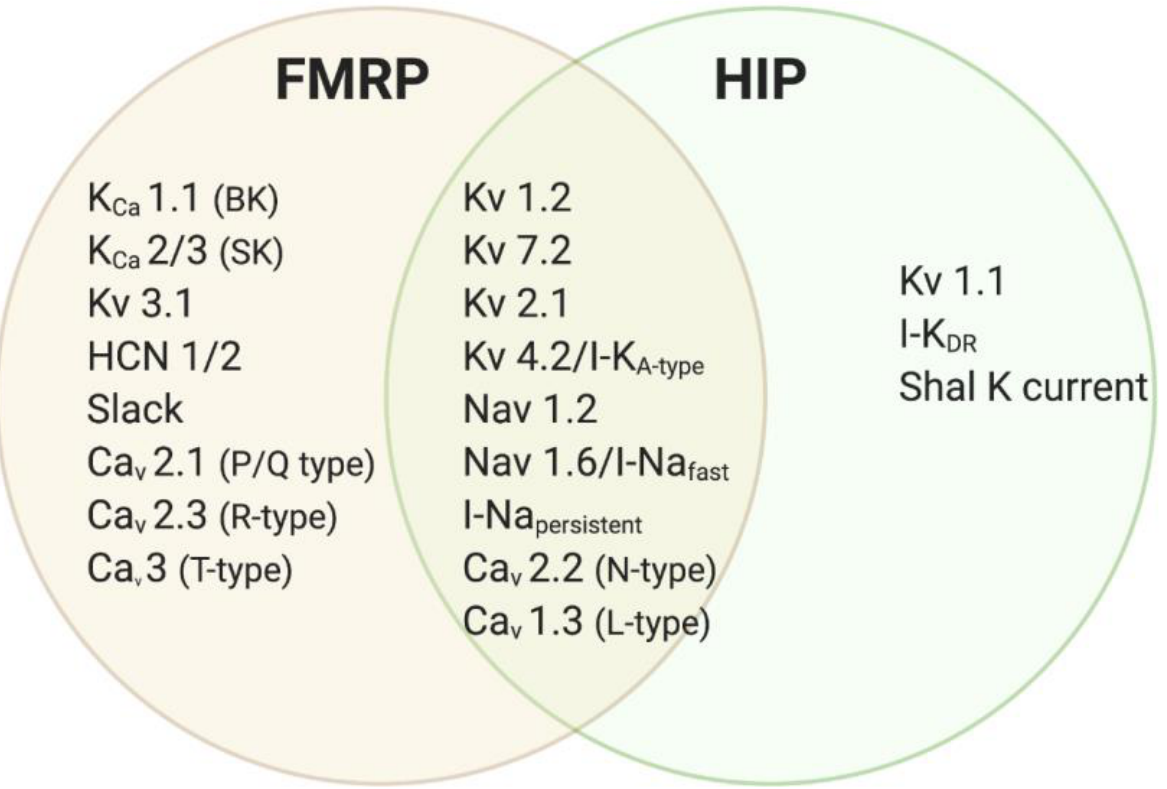
Figure 3. FMRP and Homeostatic Intrinsic Plasticity regulate distinct and overlapping groups of ion channels. Venn diagram of ion channels that are regulated by FMRP or HIP, and the subset that overlap (middle line). The ion channel regulation can be either at the level of mRNA or protein function. Note that the FMRP ion channel targets continue to be validated depending on cell type, age, and brain region. For other reviews on ion channels targeted by FMRP (see Darnell et al., 2011 [37]; Contractor et al., 2015 [4] ; Brager and Johnston, 2015 [39]).